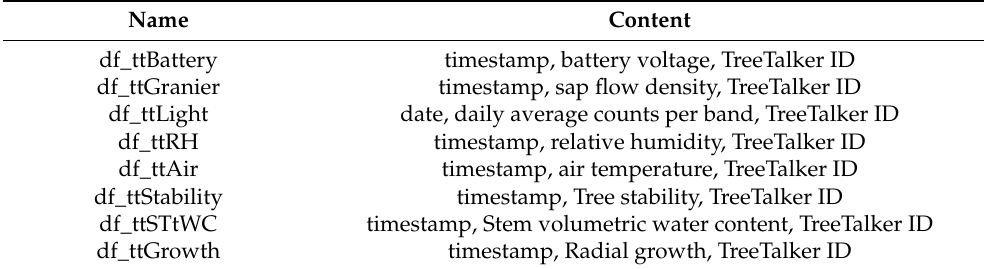
Table 1. Tables and content of the database created by means of the function ttOutput() . Name